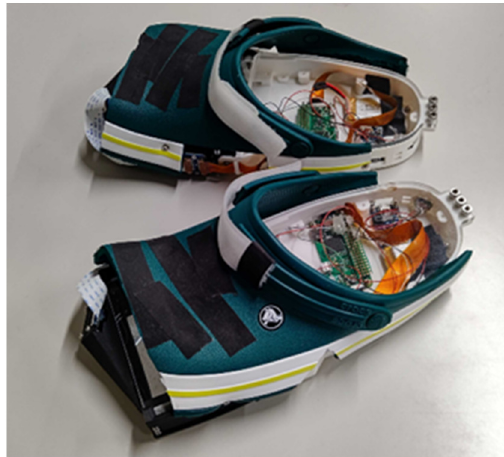
Figure 1. Sensor-integrated clogs for measuring FA and MTC.